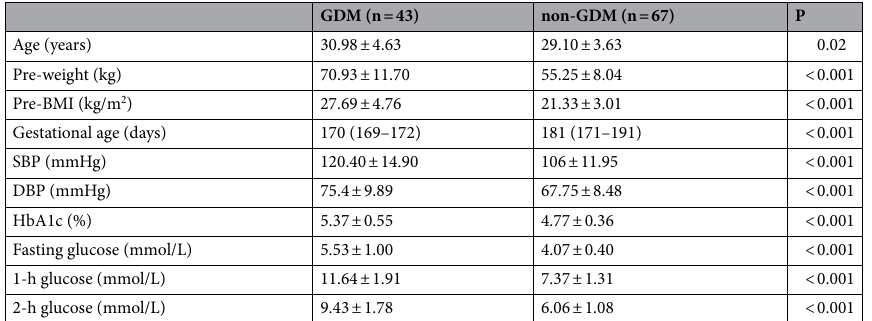
Table 1. Characteristics of the study population. Data were represented as mean ± standard deviation or median (interquartile range); Comparisons between the non-gestational diabetes mellitus (non-GDM) and the GDM groups were performed using student’s t-test except for gestational age. Comparison of gestational age between the non-GDM and the GDM groups was estimated by Mann–Whitney U test. The statistically significant difference was defined as P < 0.05. Pre-weight pre-pregnancy weight, Pre-BMI pre-body mass index, SBP systolic blood pressure, DBP diastolic blood pressure, HbA1c hemoglobin A1c, OGTT oral glucose tolerance test, 1-h glucose one-hour glucose at OGTT, 2-h glucose , two-hour glucose at OGTT.